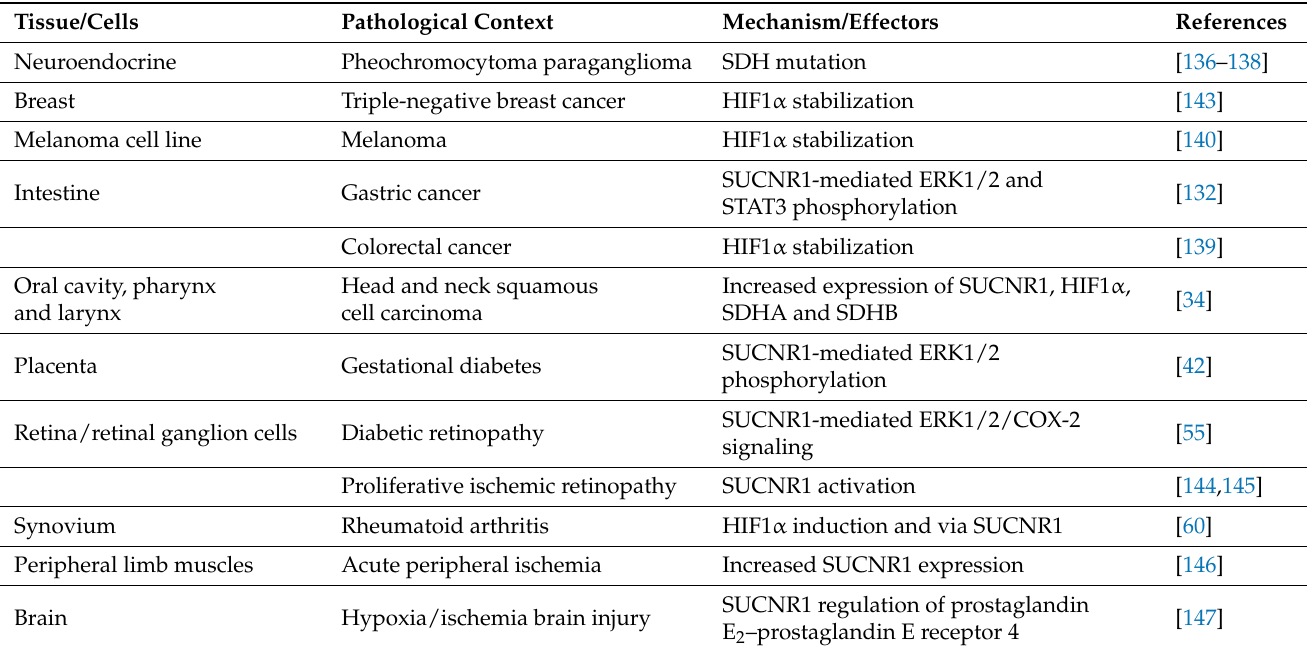
Table 1. List of studies that investigated a direct role of succinate in angiogenesis and/or tumorigenesis. Tissue/Cells Pathological Context